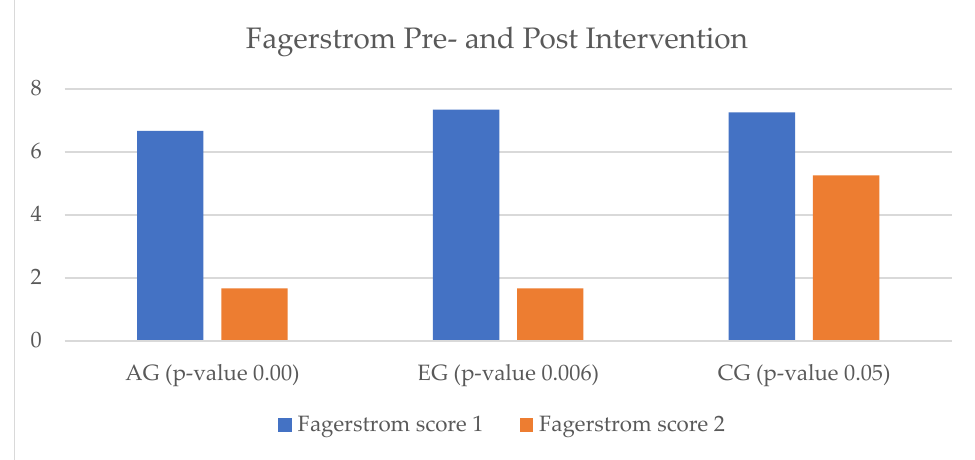
Figure 6. Smoking status of heart failure patients. HF = heart failure; AG = ambulatory group; EG = experimental group; CG = control group; T 0 = before the rehabilitation period; T 1 = after the rehabilitation period.